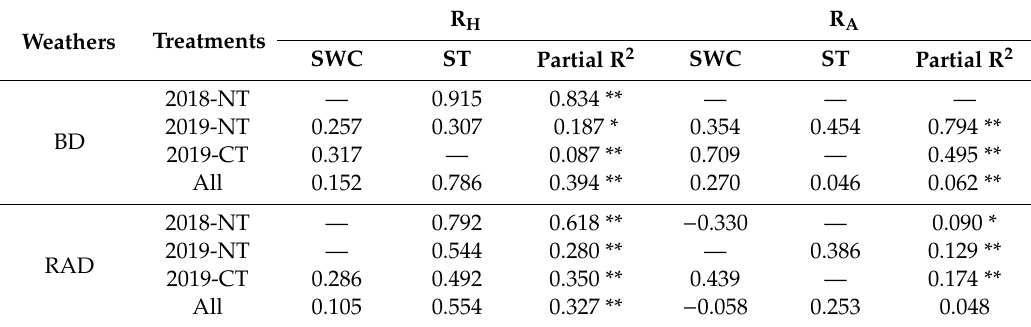
Table 3. Multiple linear stepwise regression analysis between R H and R A with soil water content (SWC) and soil temperature (ST) in 2018 and